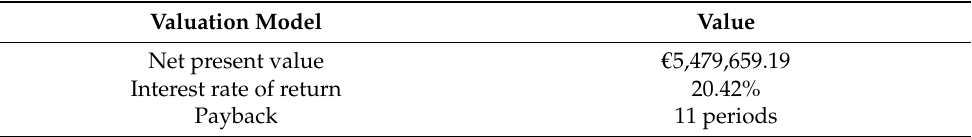
Table 4. Valuation of the seaweed company using classical